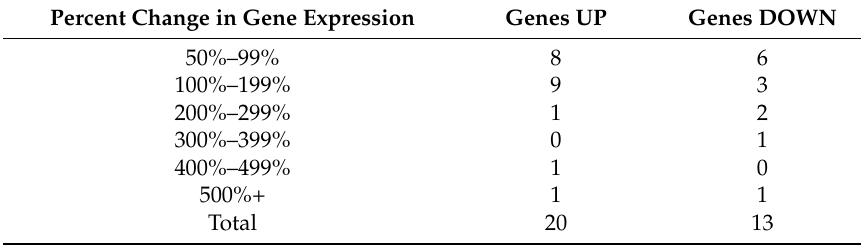
Table 29. Distribution of Genes Affected by GHK and Associated with Spinal Nerve Cells.